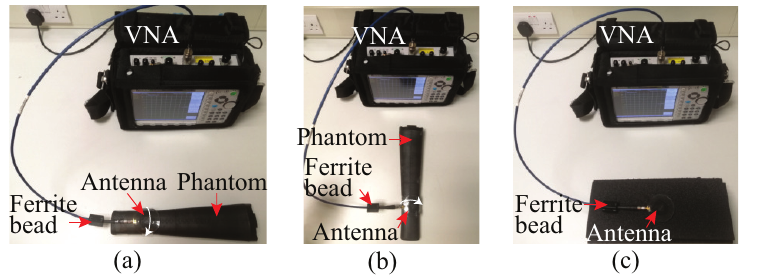
Figure 21. Antenna | S 11 | measurement set-up: ( a ) antenna bending towards the x -axis direction, ( b ) antenna bending towards the y -axis direction, and ( c ) flat